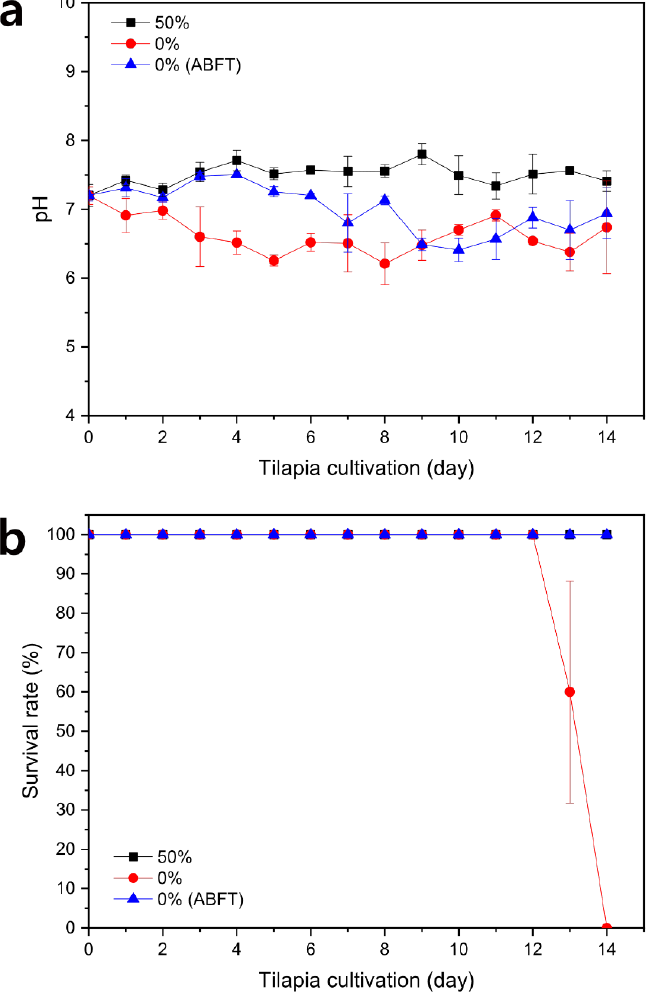
Figure 2. (a) pH-change pattern during fish cultivation and (b) Tilapia survival rates. Groups: 50% (closed squares; water replacement daily); 0% (closed circles; no water replacement); ABFT (closed triangles; no water replacement; including Chlorella ellipsoidea and Scenedesmus dimorphus